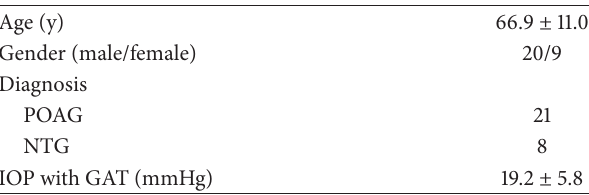
Table 1: Participant demographic data.